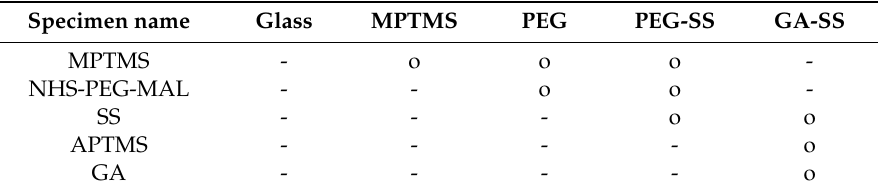
Table 1. The materials coating on the specimens’